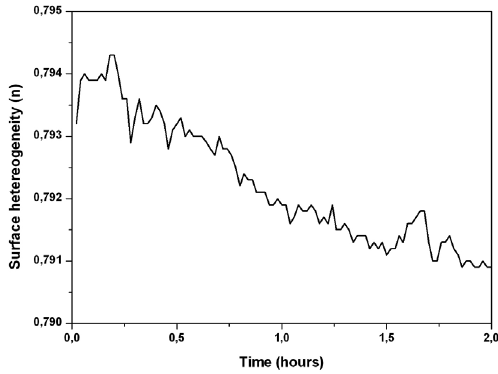
Figure 8. Surface heterogeneity ( n ) vs. time of exposure in 1500 ppm mad honey in 3.5% NaCl solution, based on the DEIS